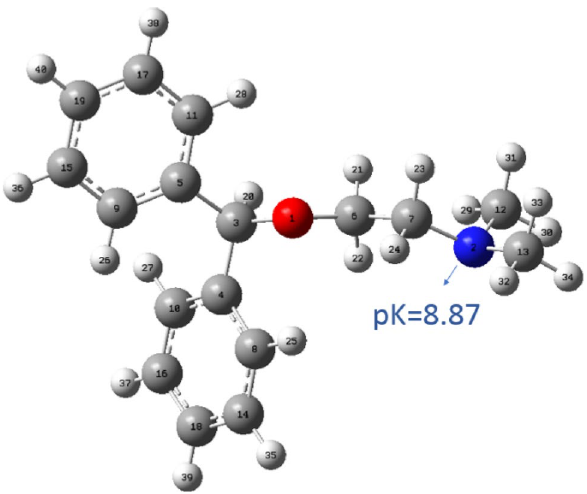
Figure 1. The chemical structure of DPH, the carbon, nitrogen, hydrogen, and oxygen are shown with cyan, blue, white, and red spheres, respectively. Also, the calculated pK value of nitrogen is